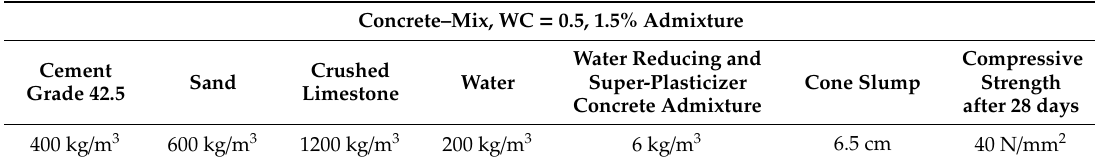
Table 1. The mix design of the used concrete.